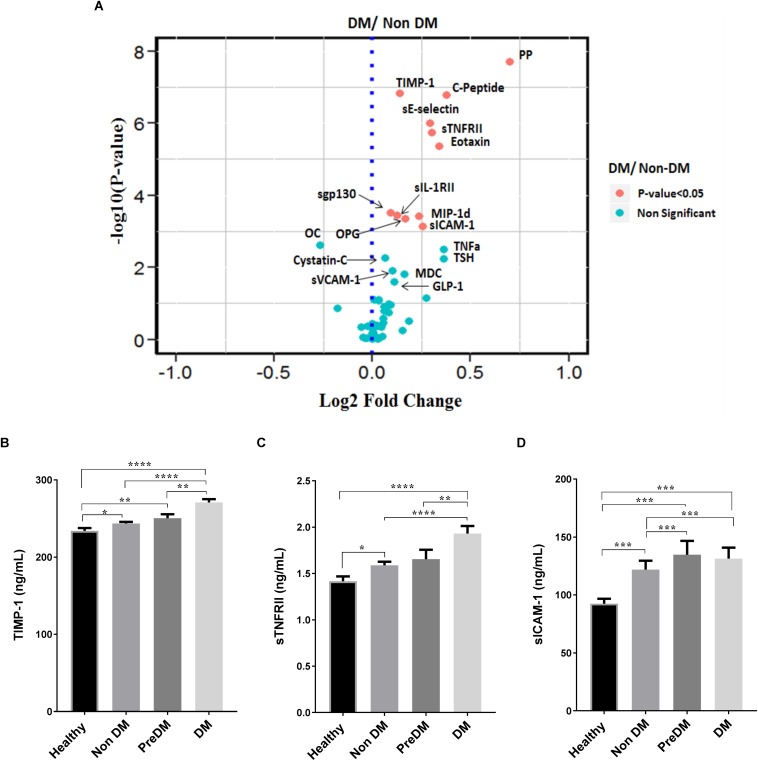
Increased inflammatory molecules in Diabetes individuals. (A) A representative Volcano plot comparing all measured molecules between DM and Non-DM individuals, red labeled dots indicate a significant difference (P < 0.05) between the two groups. Cytokine comparison between the four groups show significantly high (P < 0.05) level in DM individuals for TIMP-1 (B), sTNFRII (C), and sICAM-1 (D). The volcano plot was done by first taking the Fold change (which was calculated by dividing the average value of each molecule in DM and Non-DM individuals) and then using the log2 fold change against the –log10 P-value of each molecule. P-values were calculated using non-parametric Kruskal–Wallis test and Mann–Whitney U-test for comparing for more than two groups and for comparing between two groups, respectively, then adjusted for Bonferroni multiple test correction (ns P > 0.05, *P <0.05, **P < 0.01, ***P < 0.001, ****P < 0.0001).